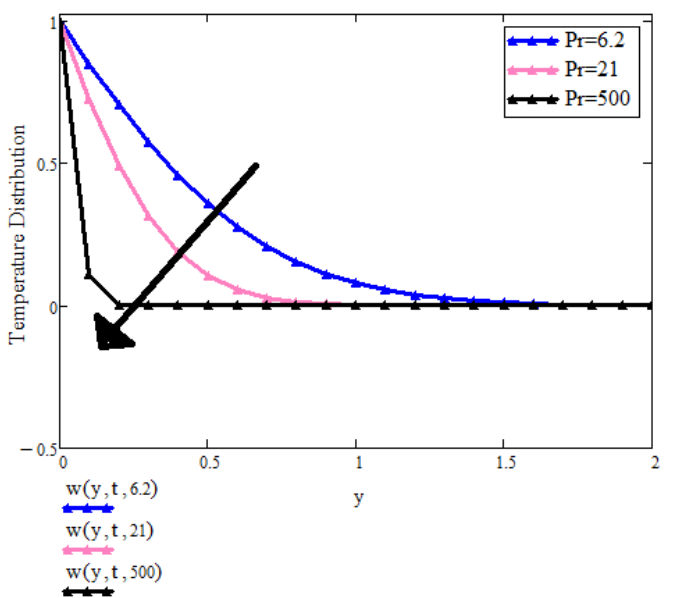
Figure 4. T ( y , t ) with Pr when t = 1, a = 0.5, λ = 0.1, Pr = 6.2, β 1 = 0.1a , φ 1 = φ 2 = φ 3 = 0.03.